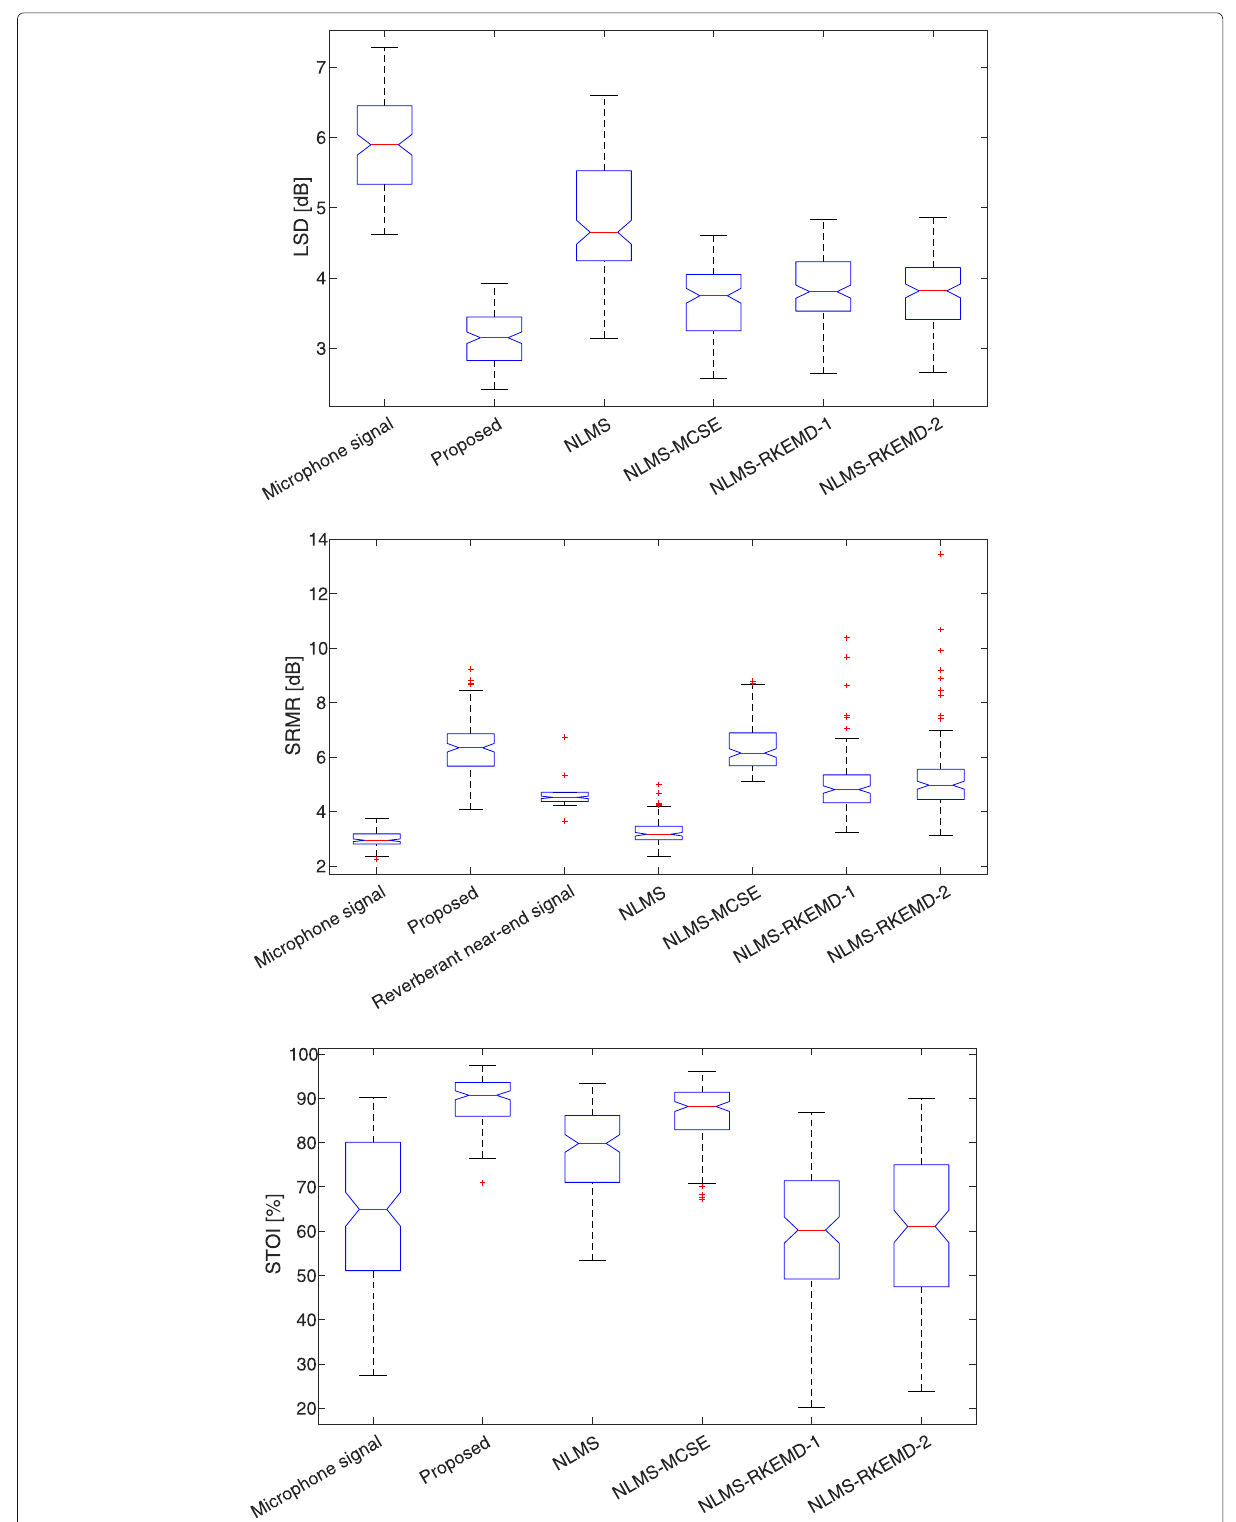
Fig. 2 Speech quality, intelligibility and dereverberation measures for Scenario #1. The microphone signal refers to Mic.1#. NLMS refers to applying NLMS alone with any dereverberation